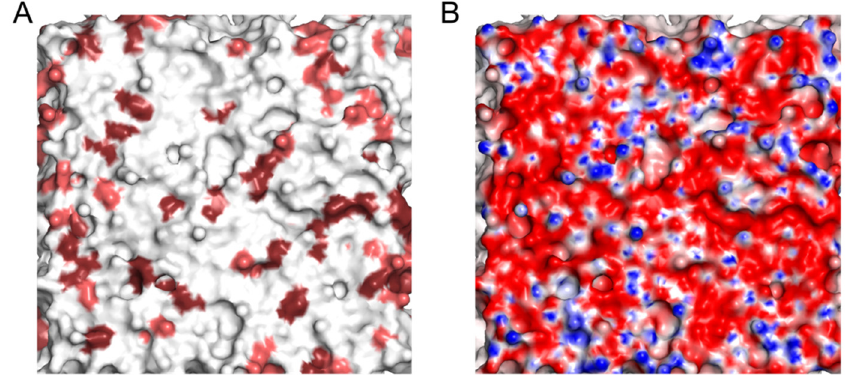
Figure 3. Equilibrated model membrane ( A ) and its surface electrostatic potential ( B ). The molecular surface of bilayer on the panel A is colored according to lipid type (PE—in white, PG—in salmon, CL—in dark ruby); the molecular surface of bilayer on the panel B is colored according to surface electrostatic potential from − 100 mV (red) to +100 mV (blue).